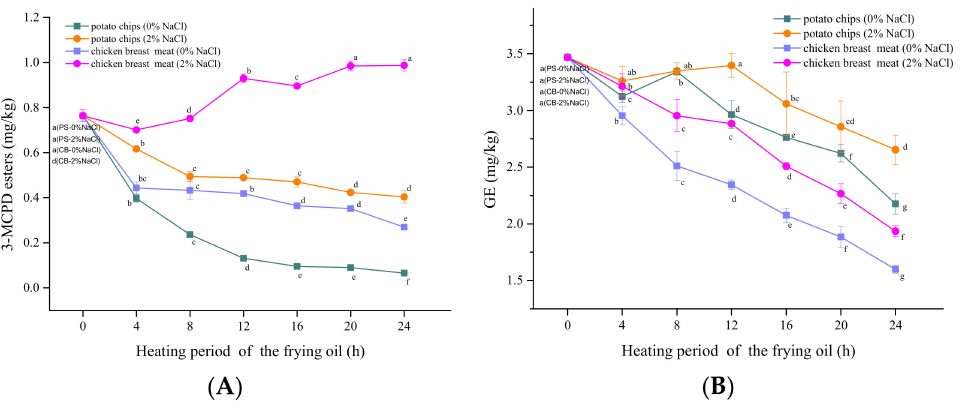
Figure 1. The content of ( A ) MCPDE and ( B ) GE fried oils of different heating periods after frying potato chips or chicken breast. Within each line, points with different letters are significantly ( p < 0.05) different from each